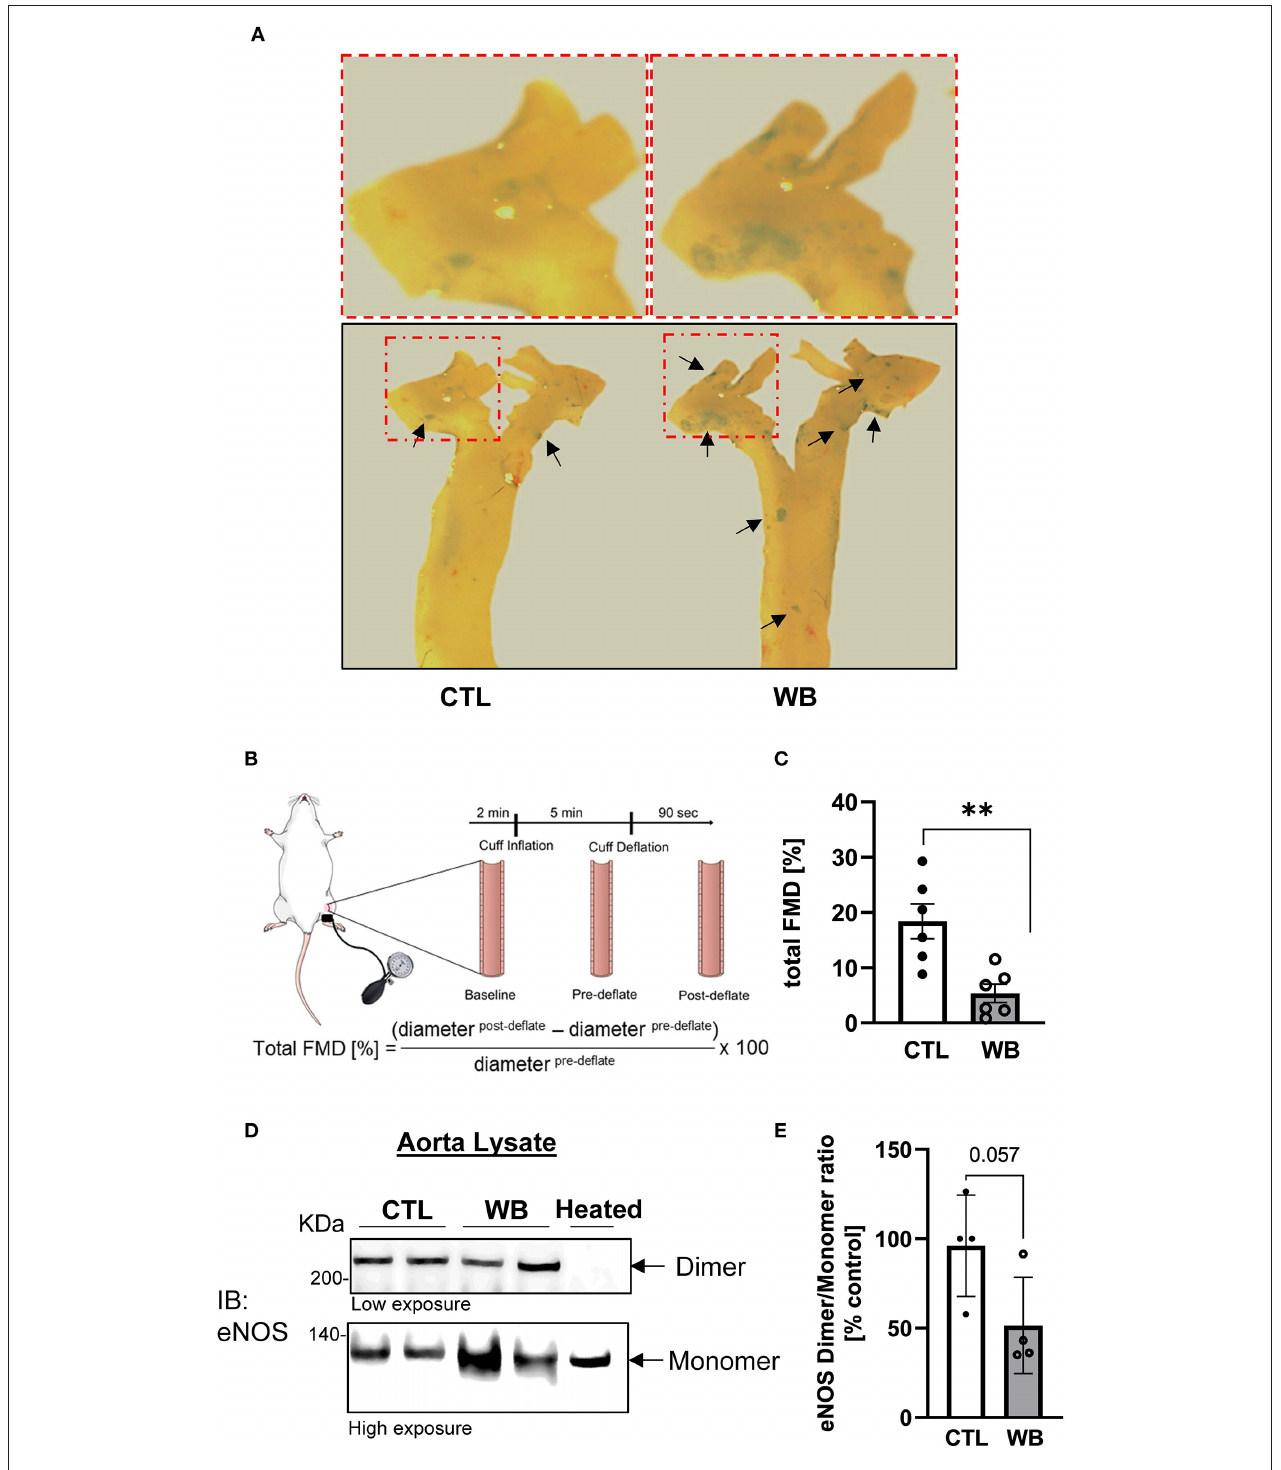
FIGURE 4 | Impaired vascular function and hyperpermeability in the aorta of weekend-binge ethanol-fed ApoE − / − mice. (A) Ethanol-induced increase in aortic permeability. Aortic permeability in control and ethanol-fed ApoE − / − mice was assessed by BSA-Evans blue dye (BSA-EBD) conjugate permeation method. Representative en face microscopy image of aortic arch segment from control and ethanol-fed mice. Area of hyperpermeability is marked by black arrows, red marked boxes indicate the area shown in higher magnification above the images. (B) Schematic representation of in vivo imaging of a mouse femoral artery for measurement of flow-mediated vasodilation (FMD). Epilated area of hindlimb is disinfected and a small incision ( ∼ 1mm) in the inner thigh is made to expose femoral artery. To